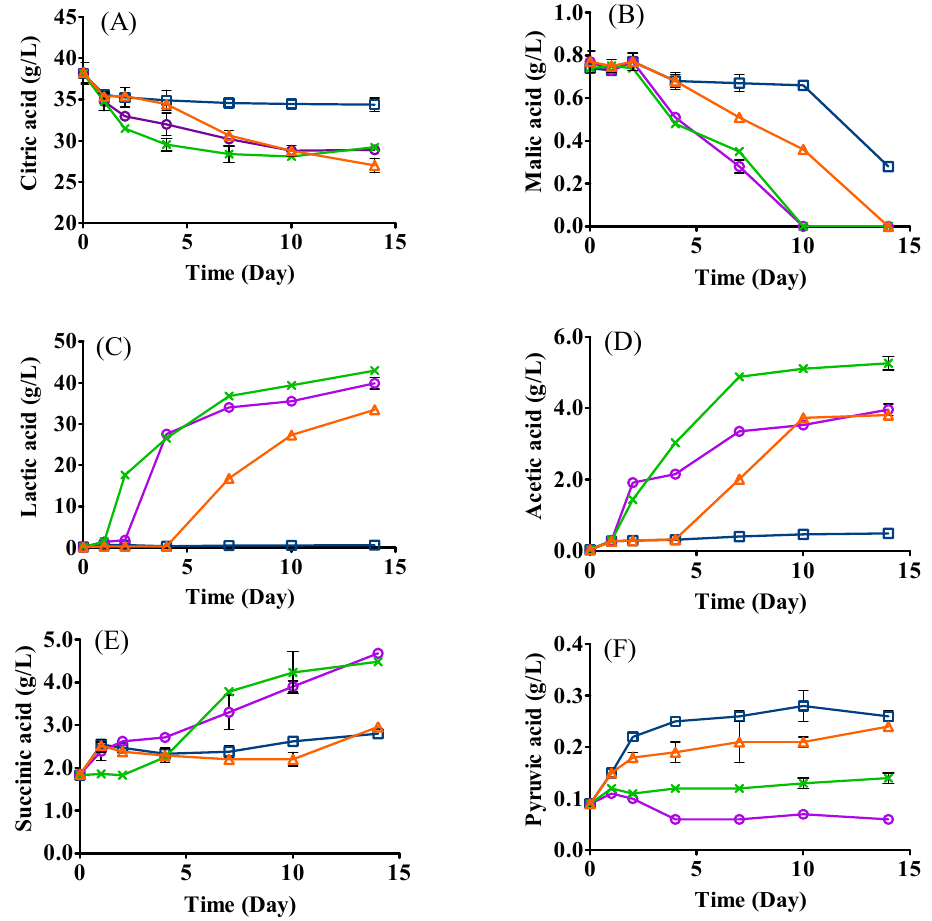
Figure 3. Changes in organic acids (( A ), citric acid; ( B ), malic acid; ( C ), lactic acid; ( D ), acetic acid; ( E ), succinic acid; ( F ), pyruvic acid) in the fermentation of SCG hydrolysates. LT ( □ ): mono-inoculation of L. thermotolerans Concerto; LP ( ○ ): mono-inoculation of L. plantarum ML Prime; LT+Co-LP (X): co-inoculation of L. thermotolerans Concerto and L. plantarum ML Prime; LT+Se-LP ( △ ): sequential inoculation of L. thermotolerans Concerto and L. plantarum ML Prime at day 4. Small amounts of pyruvic acid were generated in yeast mono- (0.26 g/L) and